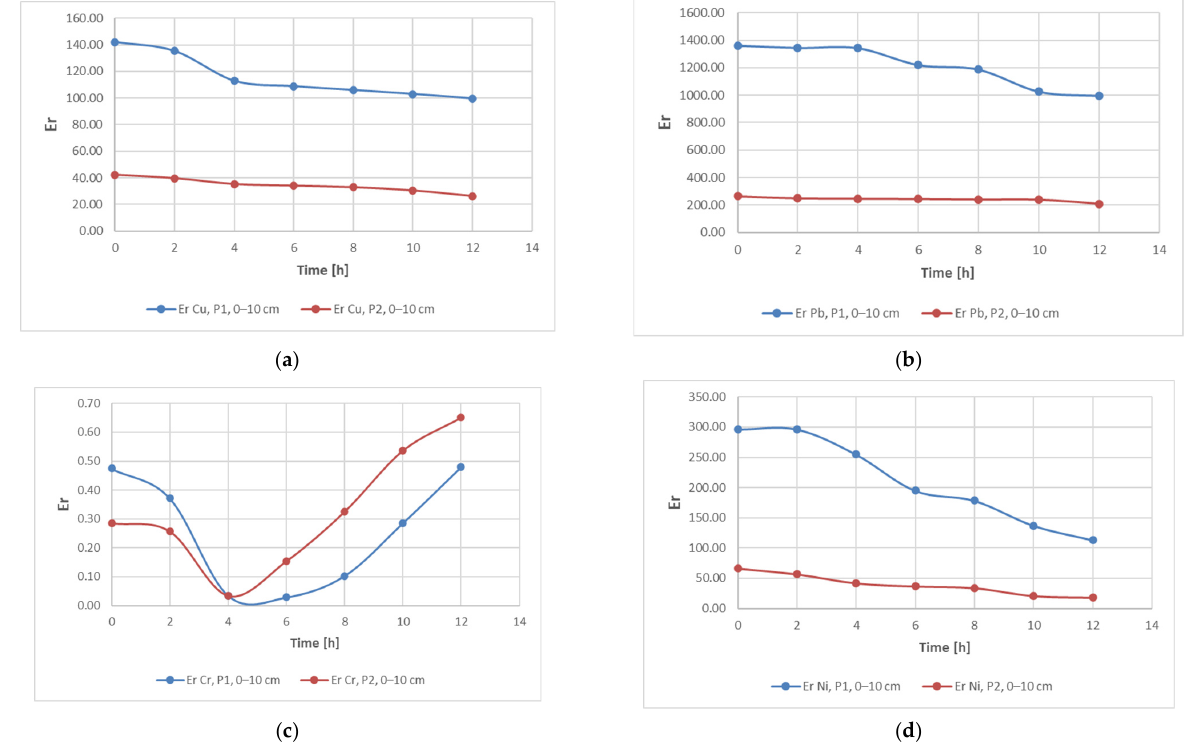
Figure 10. Evolution of the E r indicator as a function of metal, location and sampling depth: ( a ) Cu, ( b ) Pb, ( c ) Cr and ( d ) Ni. Table 3. Ecological risk index E r and PERI potential ecological risk, recorded after 12 h of treatment with 20 mL and 40 mL 9K medium solution, respectively.